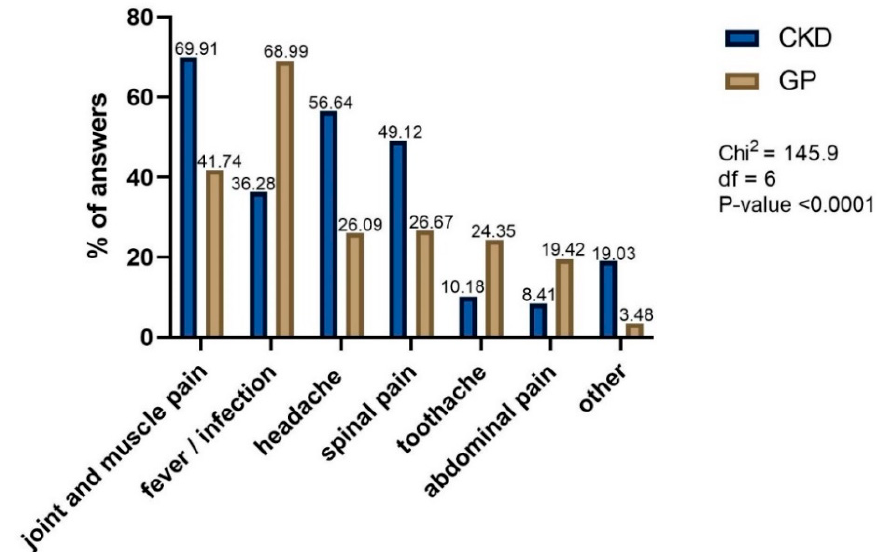
Figure 3. The indications to take OTC NSAIDs or analgesics.